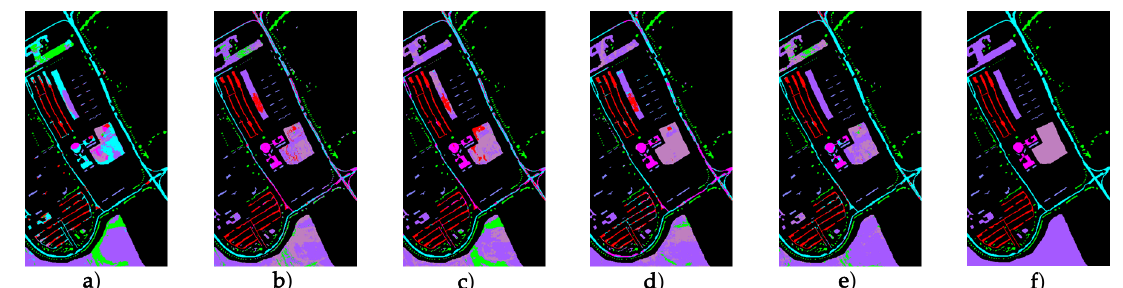
(a) Yang et al. method. (b) Mei et al. method. (c) Wang et al. +FT method. (d) First-Stage + FT. (e)